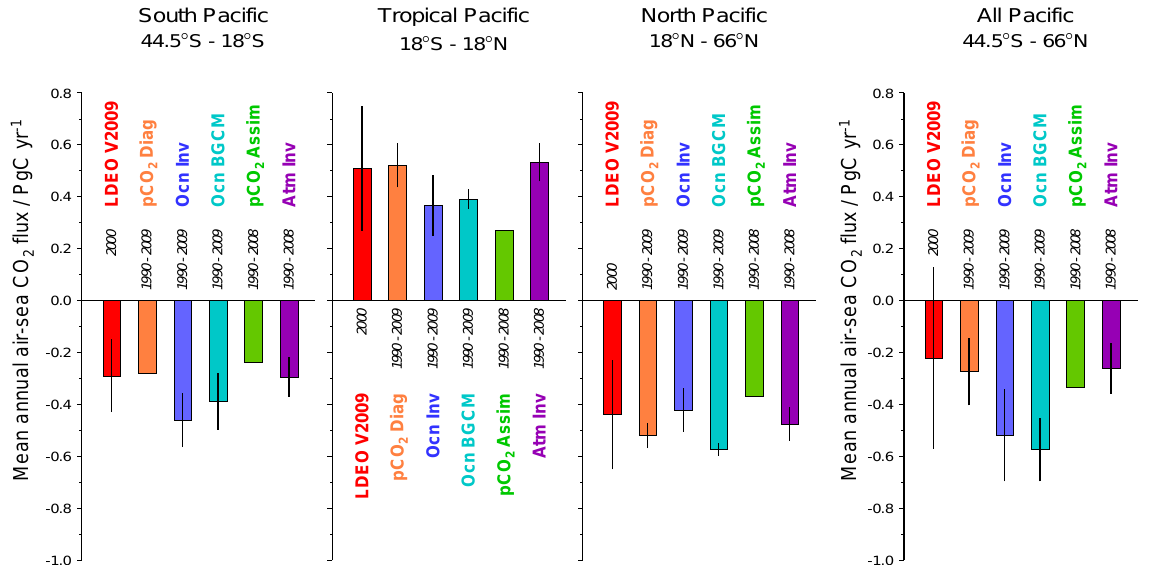
Fig. 6. Summary of regionally integrated and time-averaged net air–sea CO 2 flux (PgCyr − 1 ) in the Pacific Ocean sub-basins shown in Fig. 5.